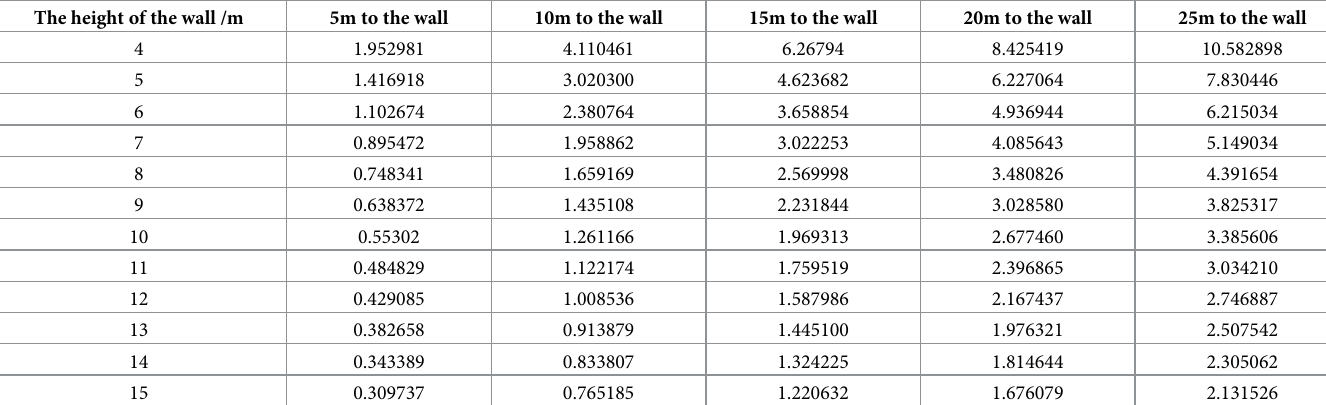
Table 6. Sheet of the width of the firing blind area of eight-Chi Yangmacheng. The height of the wall /m